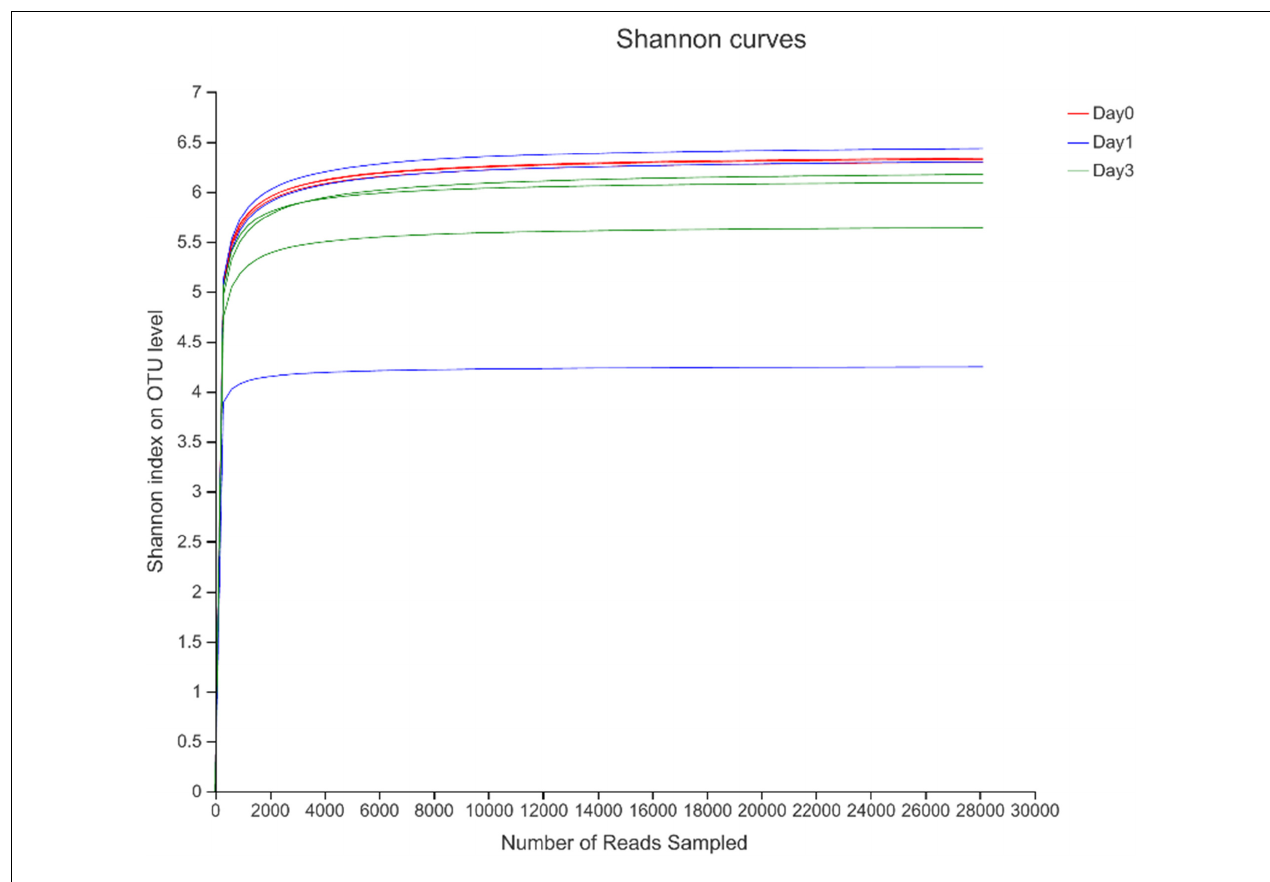
FIGURE 1 | Rarefaction analysis of high-throughput sequencing reads in samples at different storage time.